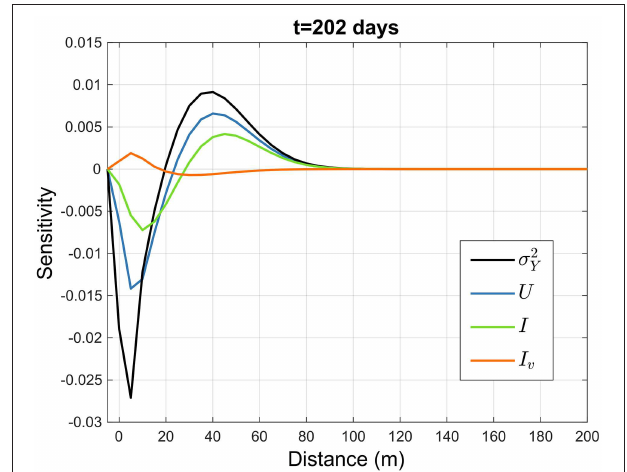
FIGURE 6 | The sensitivity function s , Equation (16), as function of the parameters σ 2 Y , U , I , I v for the snapshot at t = 202 days, MADE-1